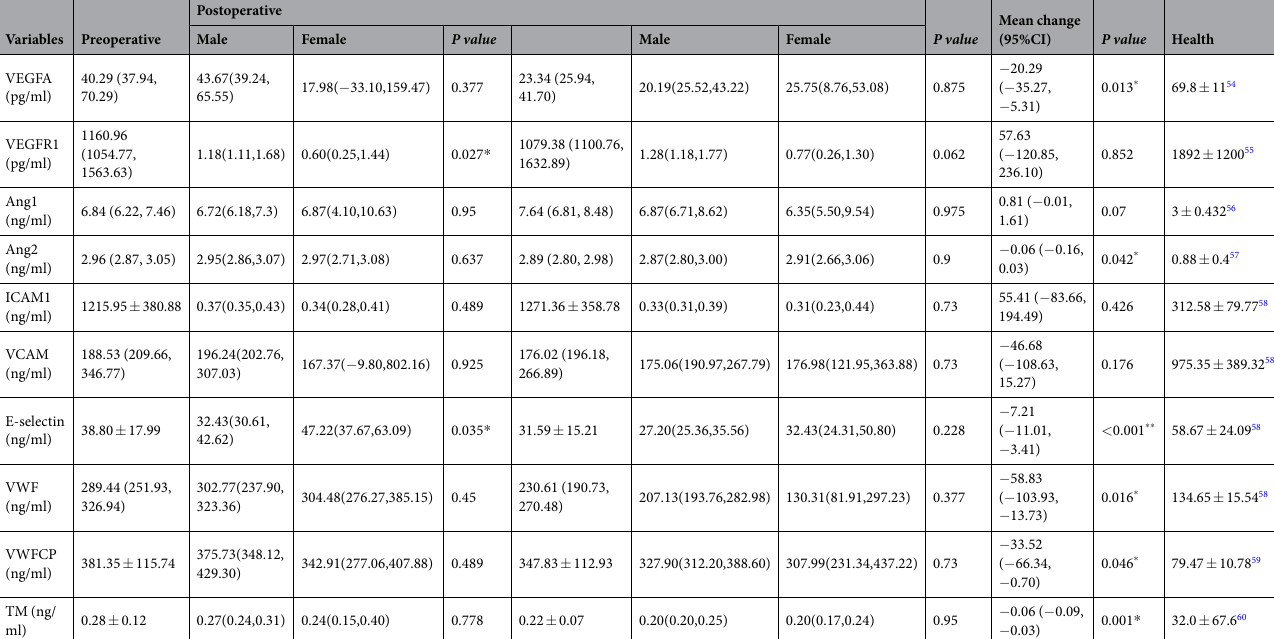
Table 3. Comparisons of serum levels of ten endothelial function-related markers between preoperative and postoperative and between male and female. Abbreviations: VEGFA = vascular endothelium growth factor A, VEGFR1 = vascular endothelium growth factor receptor 1, Ang1 = angiopoietin-1, Ang2 = angiopoietin-2, ICAM1 = intercellular adhesion molecule-1, VCAM = vascular cell adhesion molecule, E-selectin = endothelial-leukocyte adhesion molecule, VWF = von willebrand factor, VWFCP = von willebrand factor cleavage protease, TM = thrombomodulin, CI = confidence interval. * p <